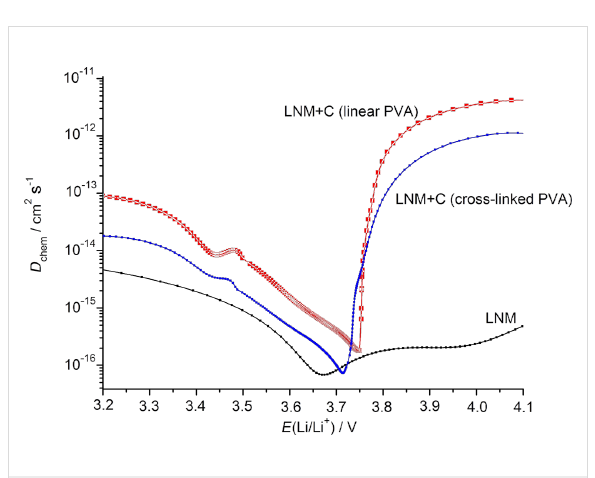
Figure 6: Apparent lithium diffusion coefficients as functions of the dis- charge potential for pure Li 1.4 Ni 0.5 Mn 0.5 O 2+ x and LNM/C nanocompos- ites obtained from linear and cross-linked